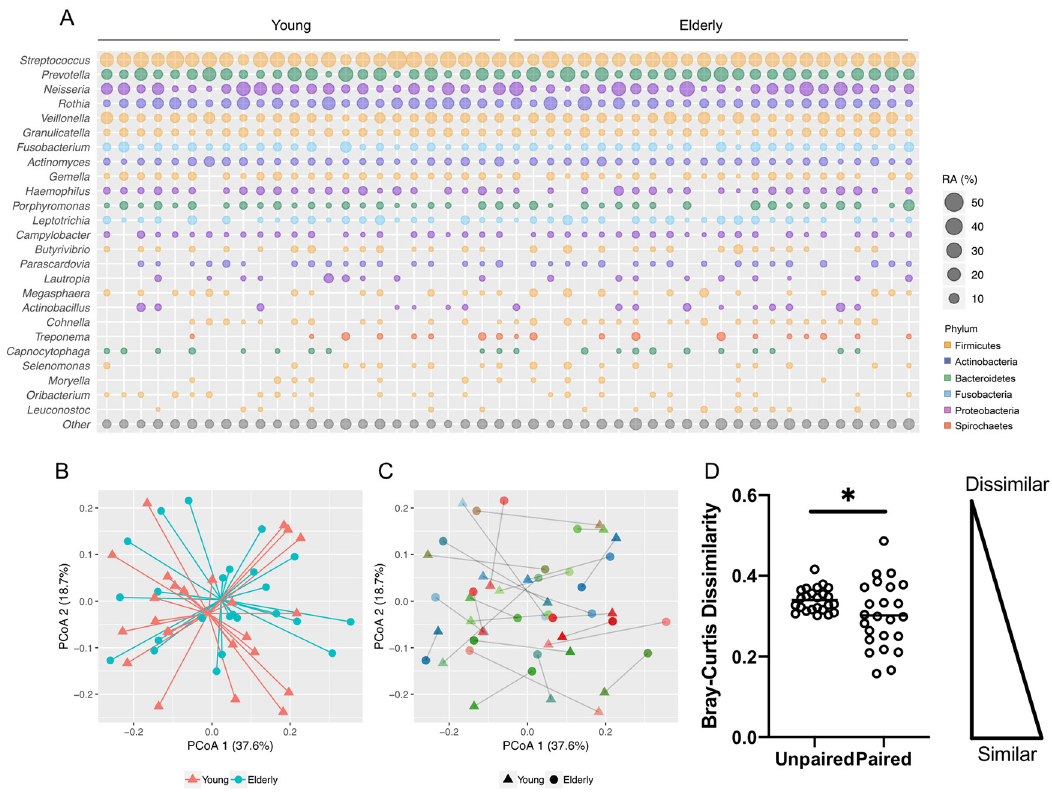
Fig 1. Lung microbiome composition in genetically paired young and elderly subjects. (A) Lung microbiome composition as detected by 16s rRNA gene profiling. Average relative abundance (RA) for the most representative taxa (present at > 1%) is illustrated by circle size. Colour denotes phylum level membership. (B) Principle co-ordinate analysis (PCoA) of Bray-Curtis distance between microbiome profiles observed in young (red triangles) and elderly (turquoise circles) cohorts. (C) PCoA of microbiome profiles indicating linked young (triangles) and elderly (circles) participant pairs. Grey lines illustrate the distance between each paired sample which also share the same colour (D) Comparison of bray-curtis distance between PCoA points illustrating the reduction in dissimilarity observed between paired, genetically-related participants. � = p <